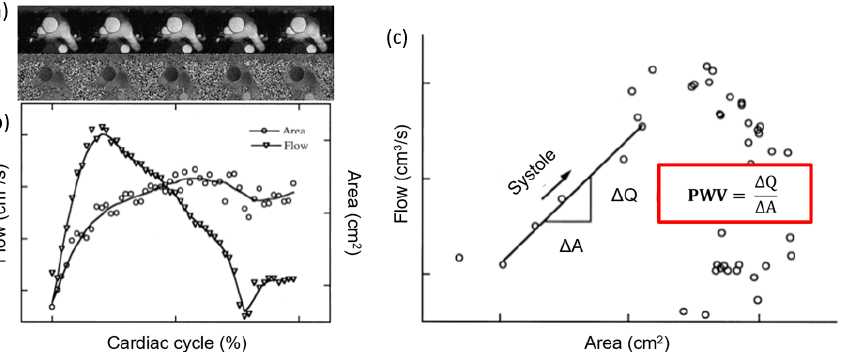
Figure 1. ( a ) Phase contrast images of an aortic section; ( b ) Through plane flow Q and area A variations along the cardiac cycle as extracted from phase contrast data segmentation; ( c ) QA loop for the estimation of the PWV as the slope of the early-systole